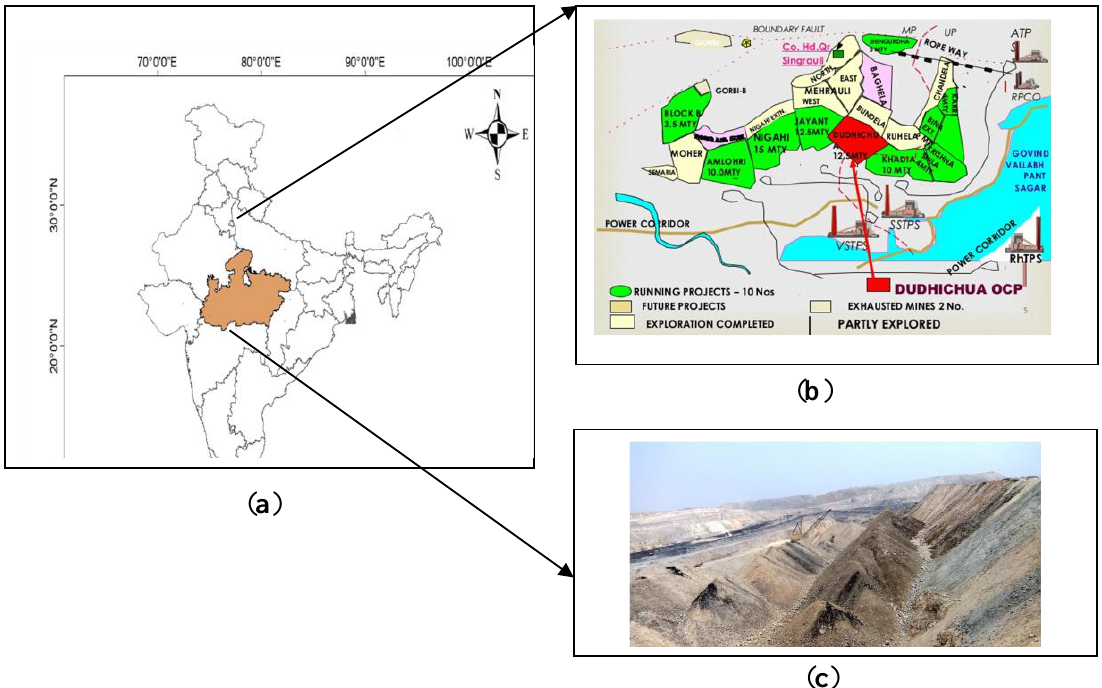
Figure 1. ( a ) Location of the study area (Madhya Pradesh, India). ( b ) Location of different project in Singrauli coalfield. ( c ) Land degradation due to dumping of overburden dumps created by draglines in the project.